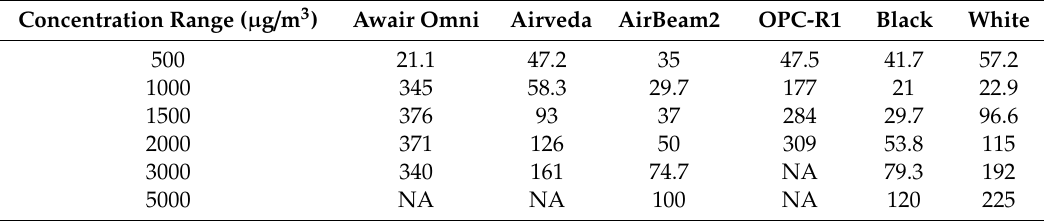
Table 4. Verification results expressed as relative uncertainty (%).